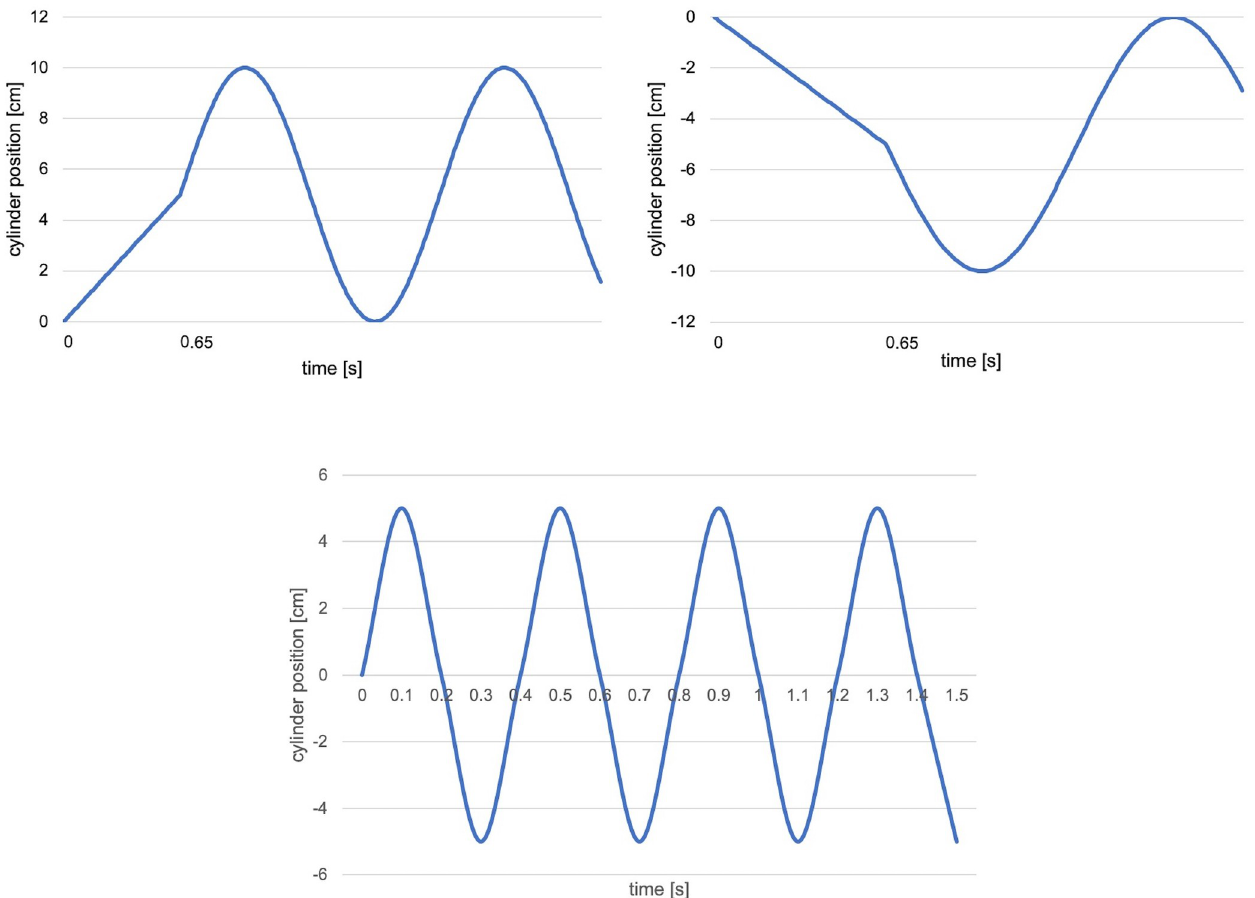
Fig 3. Implemented vertical movements. Examples of the vertical movements of the robot by combining the vertical oscillation and transition of the